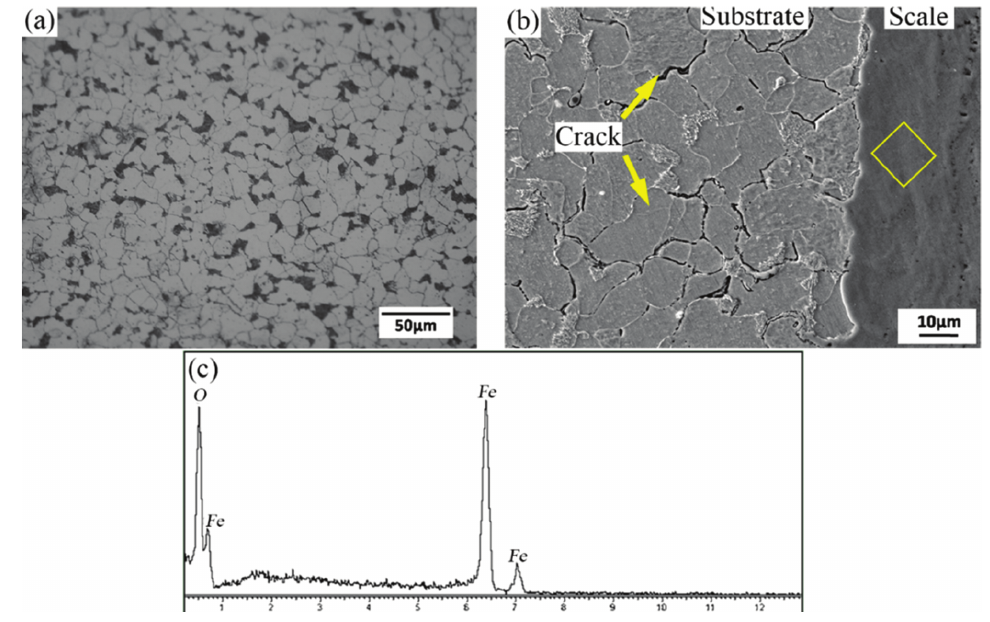
Figure 2: Microstructure of the corroded water wall